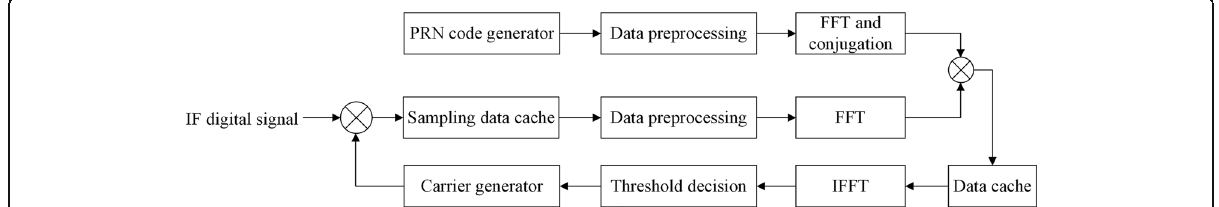
Table 1 The difference between four major constellation systems GNSS signal